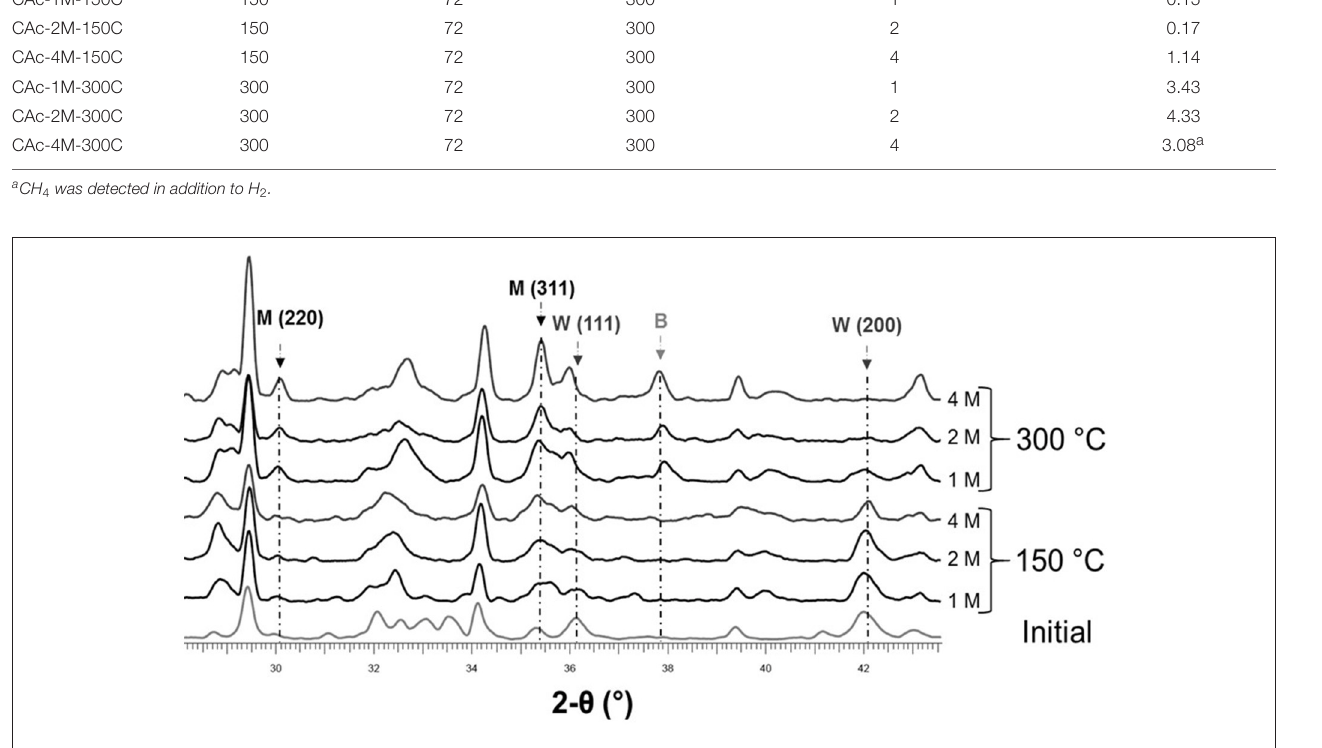
FIGURE 6 | XRPD patterns of the starting and hydrothermally treated steel slag in the presence of acetic acid at three molarities (1, 2, and 4M; see a CH 4 was detected in addition to H 2 ( Table 4 ). Experiments were performed in gold capsules at 150 and 300 ◦ C. Magnetite (M), wüstite (W) and brucite